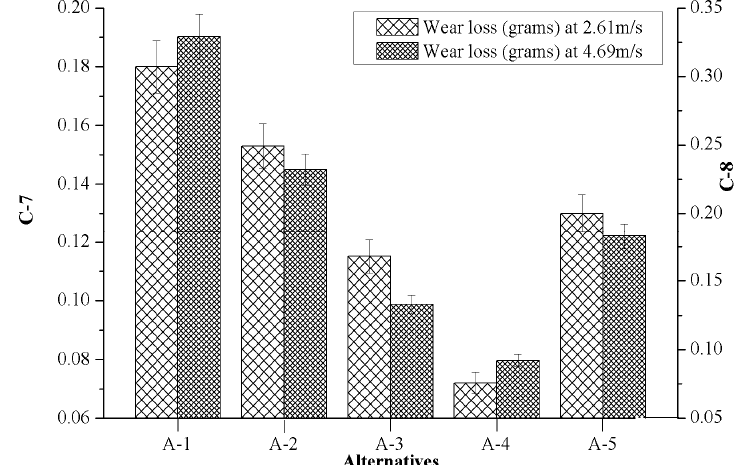
Figure 6. Evolution of criterion-7 together with criterion-8 in respect to the values of alternatives .